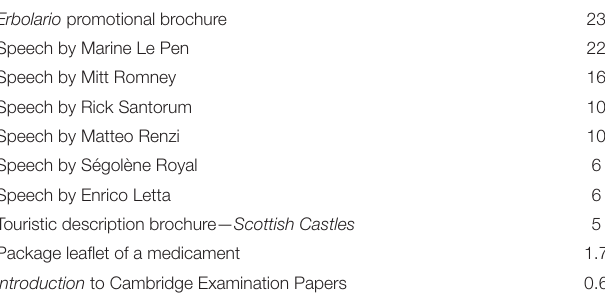
TABLE 1 | Impact of the implicit encoding of doubtful contents in different kinds of